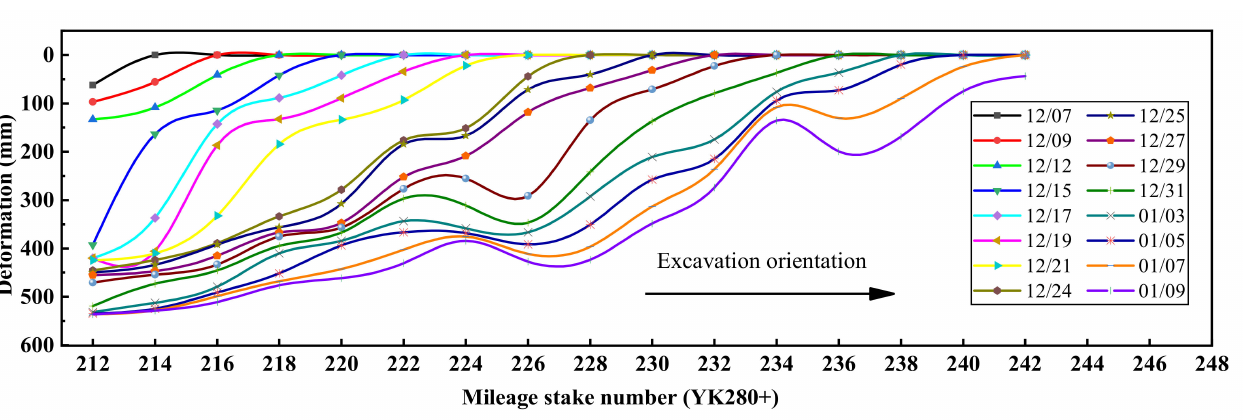
Figure 17. Distribution of initial support deformation curve of the tunnel with different scanning